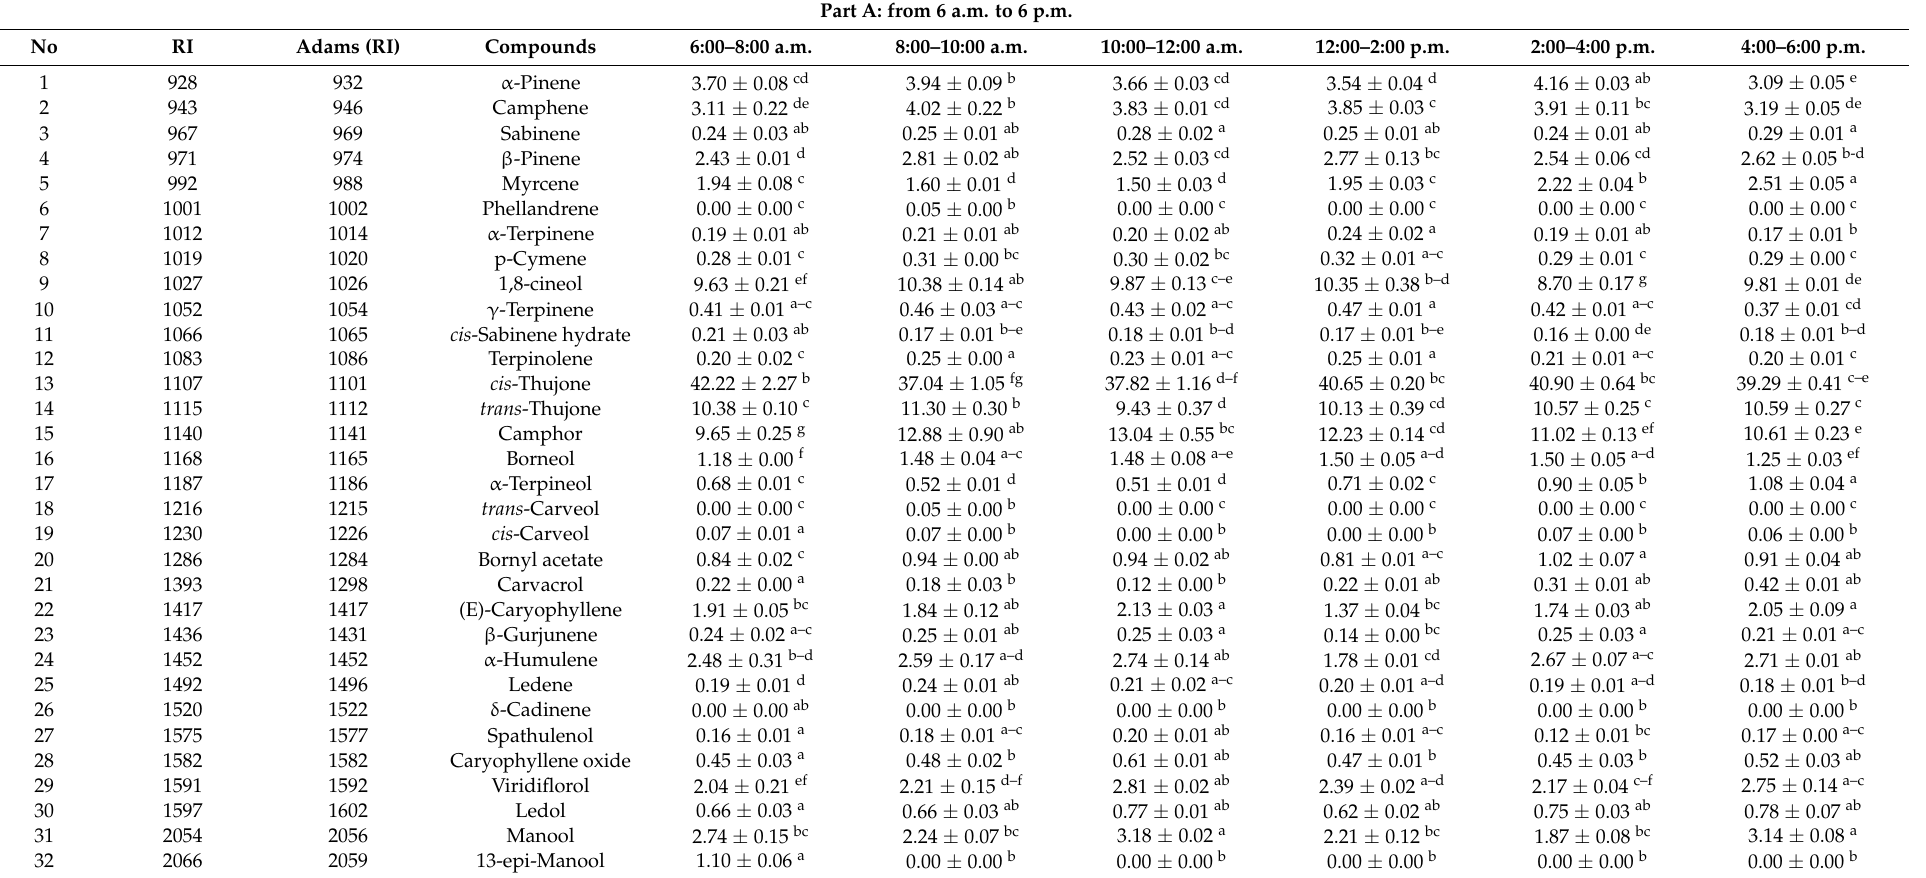
Table 2. Chemical composition of the essential oil components of S. officinalis obtained at different times of the day and night. Part A: from 6 a.m. to 6